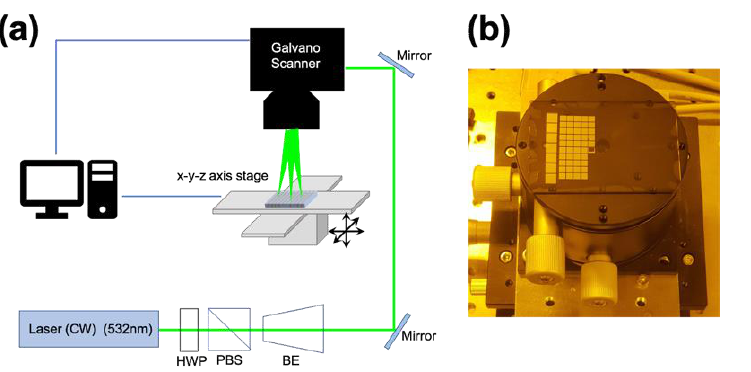
Figure 1. Laser system for sintering. ( a ) Schematic of the experimental setup, and ( b ) image during patterning on the laser system.